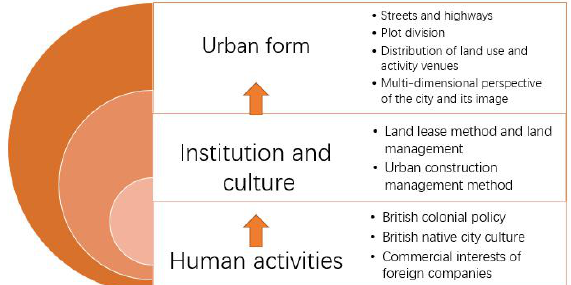
Figure 3 . Formation structure of concession space from the perspective of cultural ecology (source: